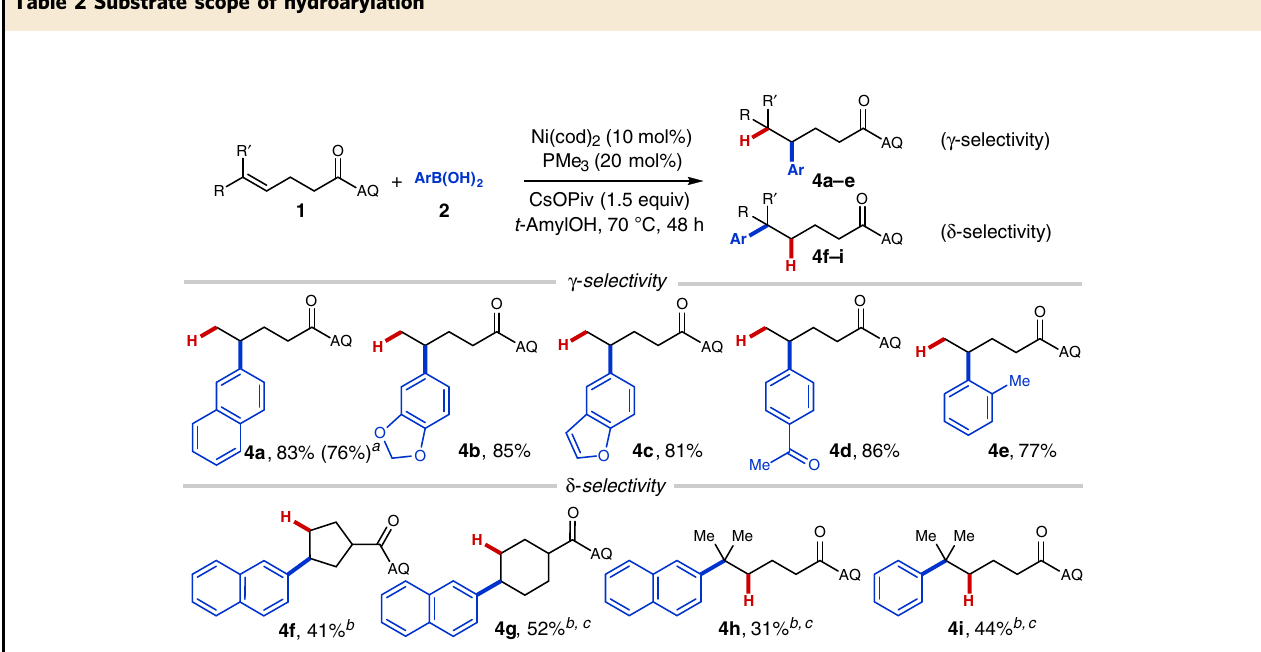
Table 2 Substrate scope of